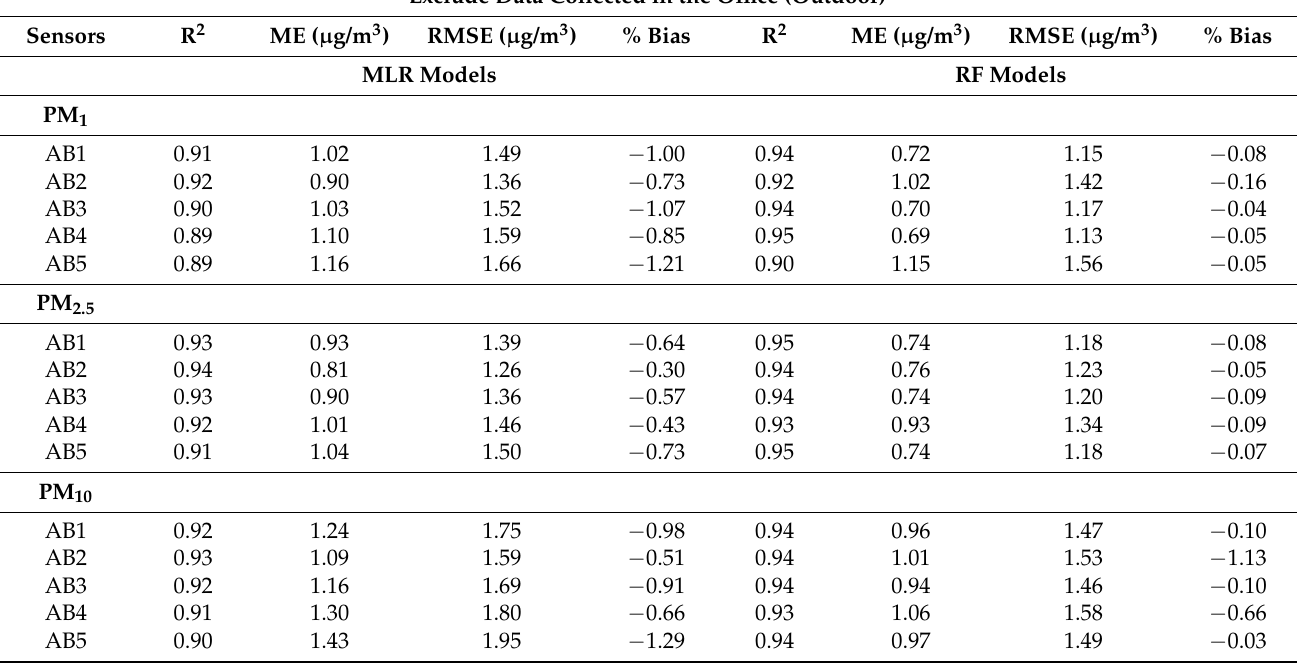
Table 5. Evaluation of 1 min PM 1 , PM 2.5 , and PM 10 average concentrations ( µ g/m 3 ) reported by AirBeam2 sensors compared with the DustTrak sensor in different